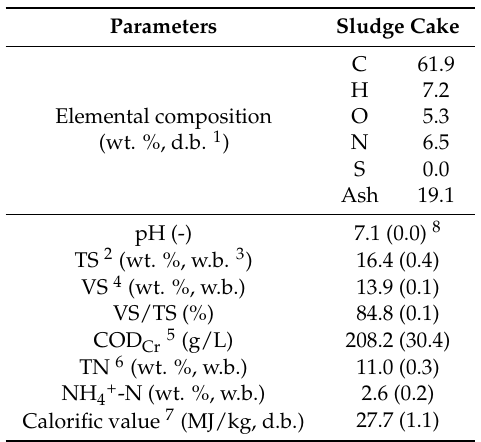
Table 2. Physicochemical properties of raw sludge